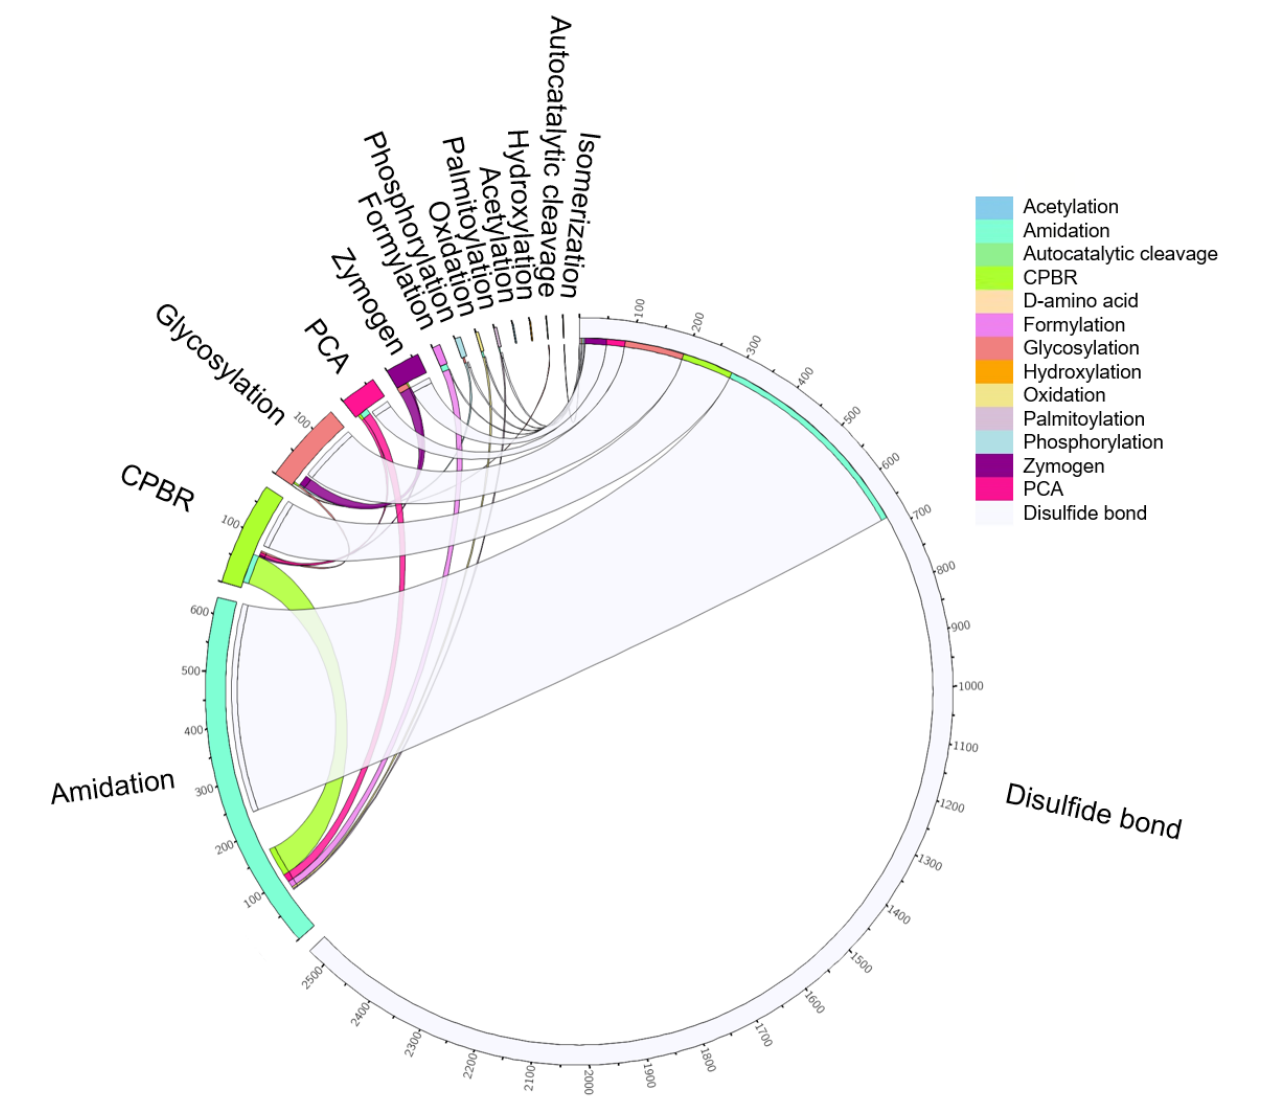
Figure 2. Protein posttranslational modifications (PTMs) in arthropod venom included in the UniProtKB/Swiss-Prot Protein Database. Circos table viewer representation of 14 PTM types identified in all the arthropod venom proteins from UniProtKB/Swiss-Prot Protein and their dual interaction when multiple PTMs were identified in one entry. The circle represents the entries with specific modification, taking into consideration different PTM combinations. This data set includes experimental and putative PTMs. The image was created in http://mkweb.bcgsc.ca/tableviewer/ [15]. PCA: pyrrolidone carboxylic acid; CPBR: cleavage on pair of basic